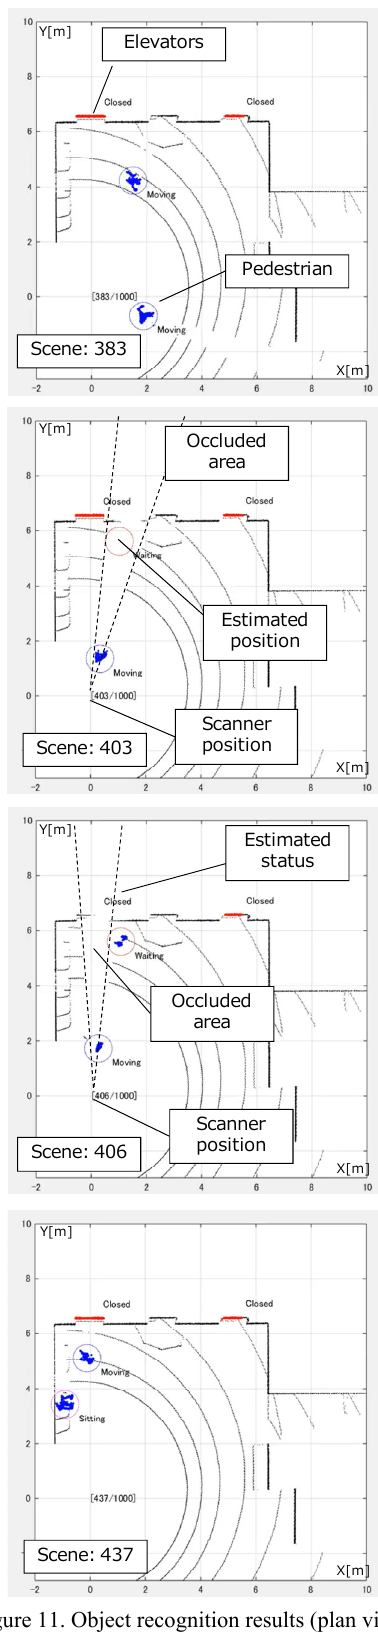
Figure 11. Object recognition results (plan